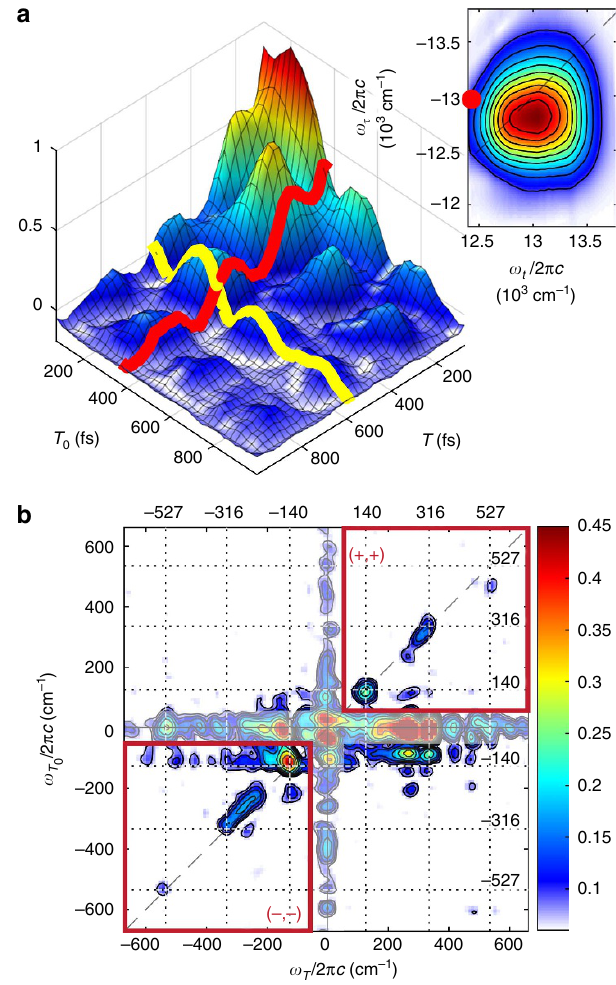
Figure 3 | Beating slices taken from the 6WM 4D GAMERS spectrum of IR-140. From the Gradient-Assisted Multidimensional Electronic Raman Spectrum (GAMERS), the top panel ( a ) shows the real-valued six-wave mixing (6WM) 2D transient taken at o t ¼(cid:4) 12 ; 640cm (cid:4) 1 and o t ¼ 12 ; 440cm (cid:4) 1 , indicated by the red dot in the absolute value 6WM 2DFTelectronic spectrum for T 0 ¼ 0 and T ¼ 100fs (inset). Red and yellow lines highlight oscillations along the T and T 0 dimensions, respectively. ( b ) A 6WM 2D beating slice spectrum exhibits Raman vibrations on the diagonal primarily in the upper right ( þ , þ ) and lower left ( (cid:4) , (cid:4) ) quadrants at ± 140, ± 316 and ± 527cm (cid:4) 1